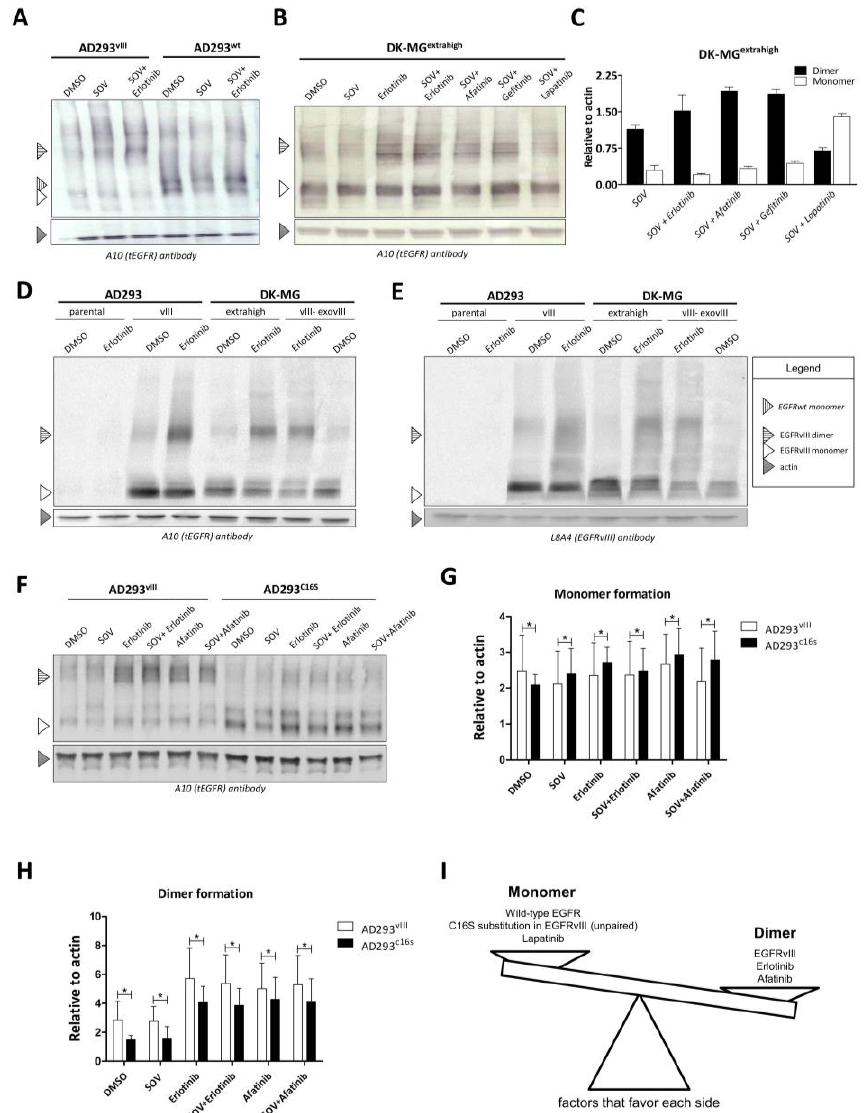
Figure 3. Mechanism of EGFR dimerization. ( A ) Semi-native Western blot demonstrating that EGFRvIII dimerization occurs via a homodimerization process that is not dependent on interaction between EGFRvIII and EGFRwt monomers. The addition of 10 µ M erlotinib for 1 h further increased the dimerization of EGFRvIII. ( B , C ) Semi-native Western blots were performed using tEGFR antibody with prior treatment of SOV and TKIs: erlotinib (10 µ M), afatinib (0.5 µ M), gefitinib (10 µ M), and lapatinib (10 µ M) ( B ). Afatinib and gefitinib demonstrate similar activity to erlotinib, whereas lapatinib significantly decreases the stability of EGFRvIII homodimers. Using ImageJ, bands were quantified via densitometry and normalized to actin ( C ). ( D , E ) Semi-native Western blot with the parallel use of A10 ( D ) and L8A4 ( E ) antibodies in lines with different EGFRvIII expression profiles (endogenous DK-MG extrahigh , exogenous DK-MG vIII-exovIII , and AD293 vIII ) or with no expression of EGFRvIII-AD293 parental was performed to verify the potential differences in dimerization and antibody binding. The results indicate the same level of dimerization independent of the expression profile. Differences in EGFRvIII expression also do not affect the binding of antibodies. The addition of 10 µ M erlotinib increased dimer formation. ( F ) Substitution of cysteine with serine in position 16 of EGFRvIII protein expressed in AD293 cell line significantly decreased the number of formed dimers and indicated that this cysteine is involved in disulfide bridge formation. In both cases, EGFRvIII and C16S, treatment of cells with TKIs such as 10 µ M erlotinib or 0.5 µ M afatinib for 1 h enhanced and